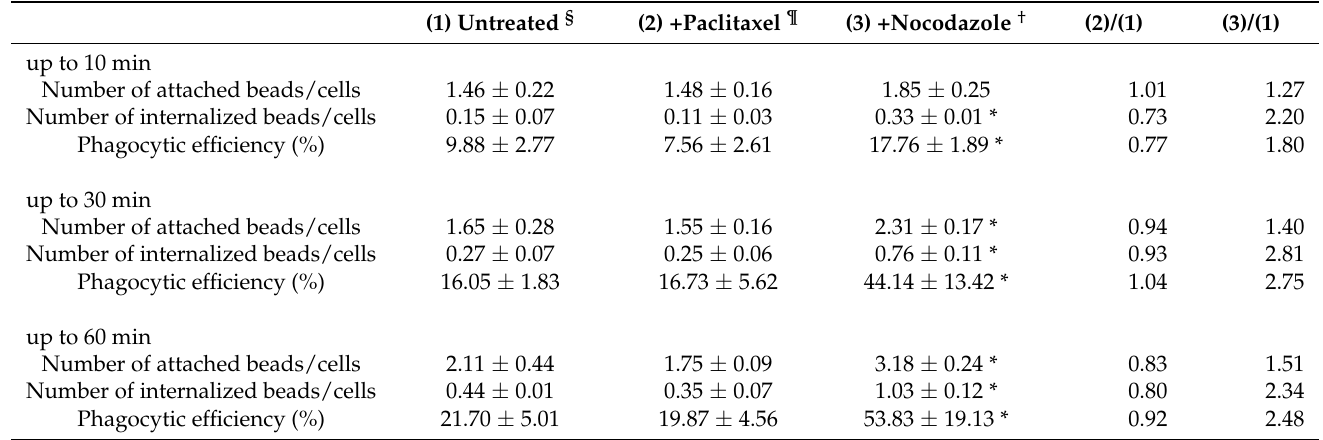
Figure 2. Effect of microtubule stabilization/destabilization on phagocytic activity. ( a ) THP1-derived macrophages treated with (+) paclitaxel or nocodazole and an untreated macrophage were stained with an anti- α -tubulin antibody (red), phalloidin (green), and DAPI (blue). Scale bars: 10 µm. ( b , c ) The phagocytic activities of the macrophages were measured as IBRf. Each bar indicates a value relative to that of the untreated control 10 min after the addition of the beads. Error bars represent standard deviations. At any time in this experiment, the phagocytic activities of the macrophages treated with these inhibitors were not significantly different from the concurrent untreated control group (ANOVA; n = 3, p > 0.05). Table 1. Effect of microtubule stabilization/destabilization on bead